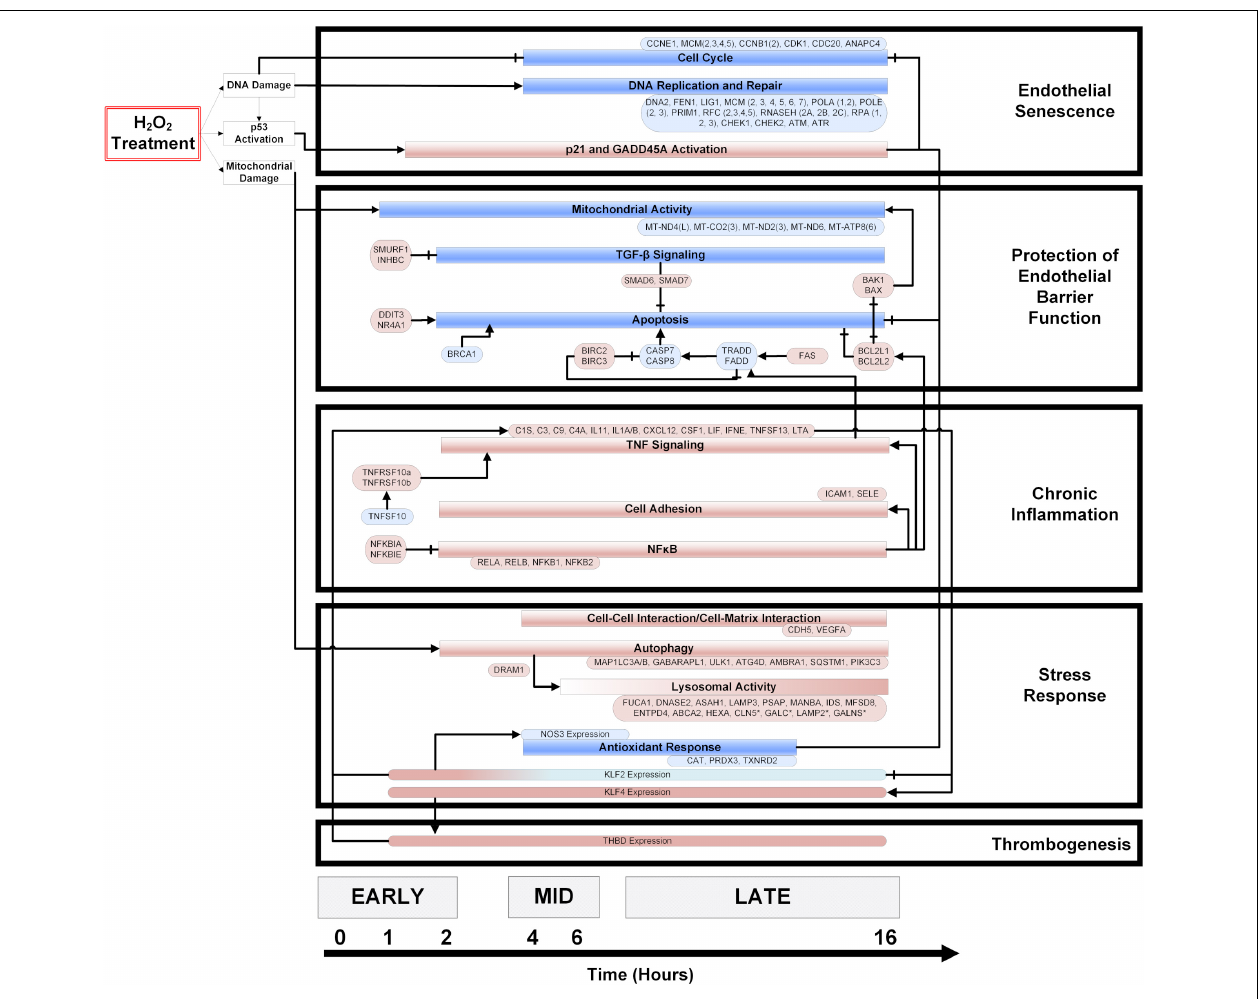
FIGURE 2 | A temporal model of HP induced oxidative stress in HUVECs. HUVECs treated with 0.5 mM HP in duplicate, and mRNA samples (from 0 to 16 h) were sequenced. Significantly regulated genes and cellular processes ( p < 0.05) were used to construct a temporal model depicting oxidative stress response time-course. The boxes colored in blue and red represent down- and up-regulated genes or processes, respectively. The axis at the bottom of the figure indicates the time at which various processes become significantly regulated. An arrowhead depicts positive regulation, and a flat line indicates negative regulation. Vascular phenotypes associated with each group of genes/processes (i.e., endothelial senescence, protection of endothelial barrier function, chronic inflammation, stress response, and thrombogenesis) are indicated to the right of the temporal model. The log 2 (fold-change) values for the genes specified in this model are summarized in the Supplementary Figure 3